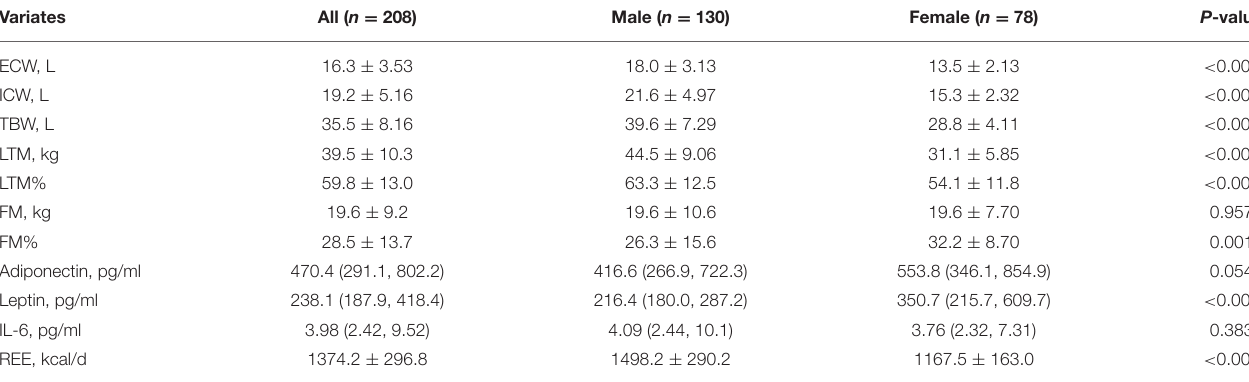
TABLE 2 | Serum adipokines, body composition and REE in male and female groups.